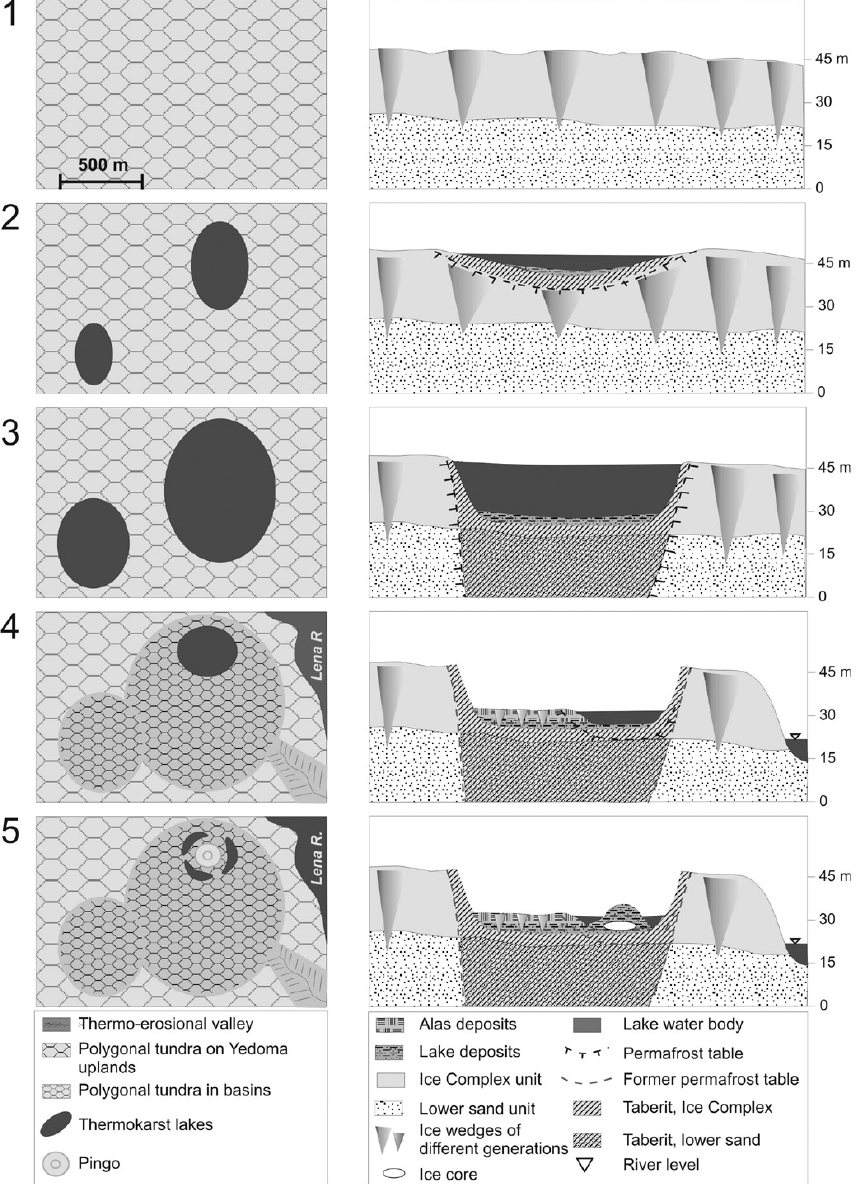
Fig. 13. Scheme of thermokarst development in Yedoma landscapes of the Lena River Delta in plane view (left) and cross section (right). 1: Flat, undisturbed Yedoma uplands with polygonal tundra. 2: Thermokarst lakes on Yedoma uplands – initial stage with lateral and vertical thermokarst development, lake sedimentation, talik in non-steady state. 3: Thermokarst lakes on Yedoma uplands – mature stage with lateral expansion only, lake sedimentation, talik fully developed. 4: Partially drained, coalesced thermokarst basin with remaining or second- generation thermokarst lake – partial refreezing of former talik, taberites, and lake sediments with ice aggradation and peat accumulation. 5: Partially drained coalesced thermokarst basin with